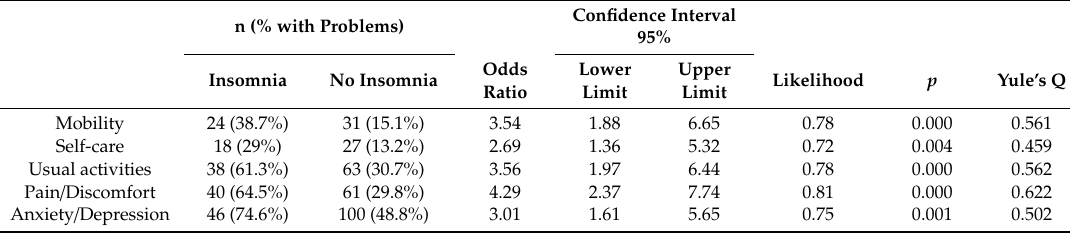
Table 3. Logistic regression